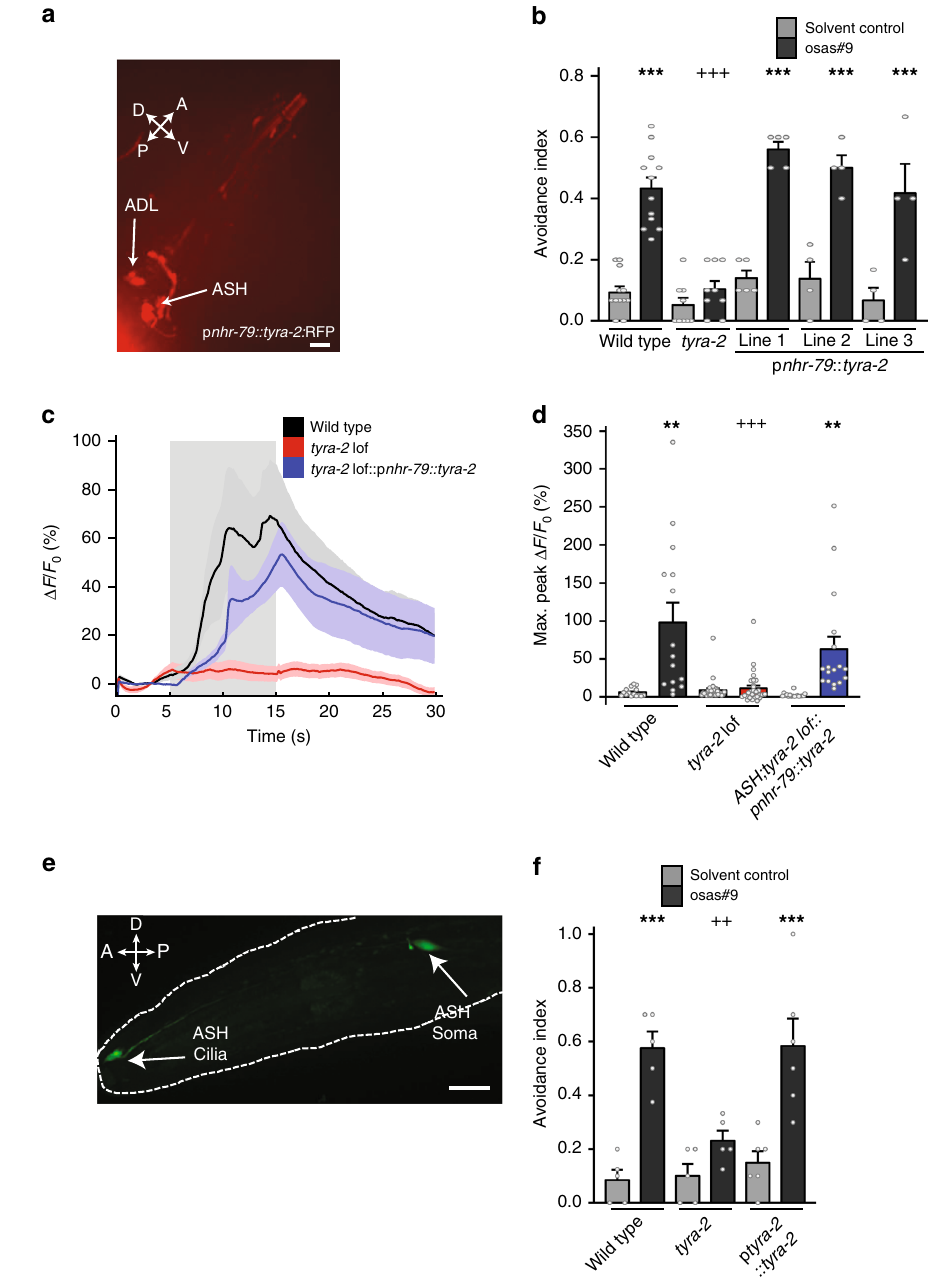
Fig. 4 t yra-2 expression in sensory neurons is required for sensitivity to osas#9. a A transcriptional rescue construct, p nhr-79 :: tyra-2 ::RFP, exhibits expression of tyra-2 in both ASH and ADL neurons (×40 magni fi cation, scale bar denotes 10 µ m). b Rescue of tyra-2 in ASH/ADL neurons fully reconstituted behavioral response to 1 µ M osas#9. n ≥ 4 trials. c Rescue of tyra-2 in ASH neurons in a tyra-2 lof (blue) background show no difference compared to calcium transients of wild type animals expressing GCaMP3 in ASH neurons (black) when exposed to 1 µ M osas#9 (gray-shaded region), while tyra-2 lof animals show a clear loss of calcium transcients in ASH (red), n ≥ 10 animals. d Maximum fl uorescence intensity in transgenic worms before (solvent control) and during exposure to 1 µ M osas#9. e Sub-cellular localization of tyra-2 . A translational reporter of the entire tyra-2 genomic locus (p tyra- 2:: tyra-2:: GFP) was injected into tyra-2 lof animals at 1 ng/ µ L, revealing expression of the receptor in both soma and sensory cilia. (60x magni fi cation, scale bar denotes 20 µ m). f Expression of the translational reporter restores wild type behavior in a tyra-2 lof background, n ≥ 5 trials. Data presented as mean ± S.E.M; * p < 0.05, ** p < 0.01, *** p < 0.001. One factor ANOVA with Sidak ’ s multiple comparison